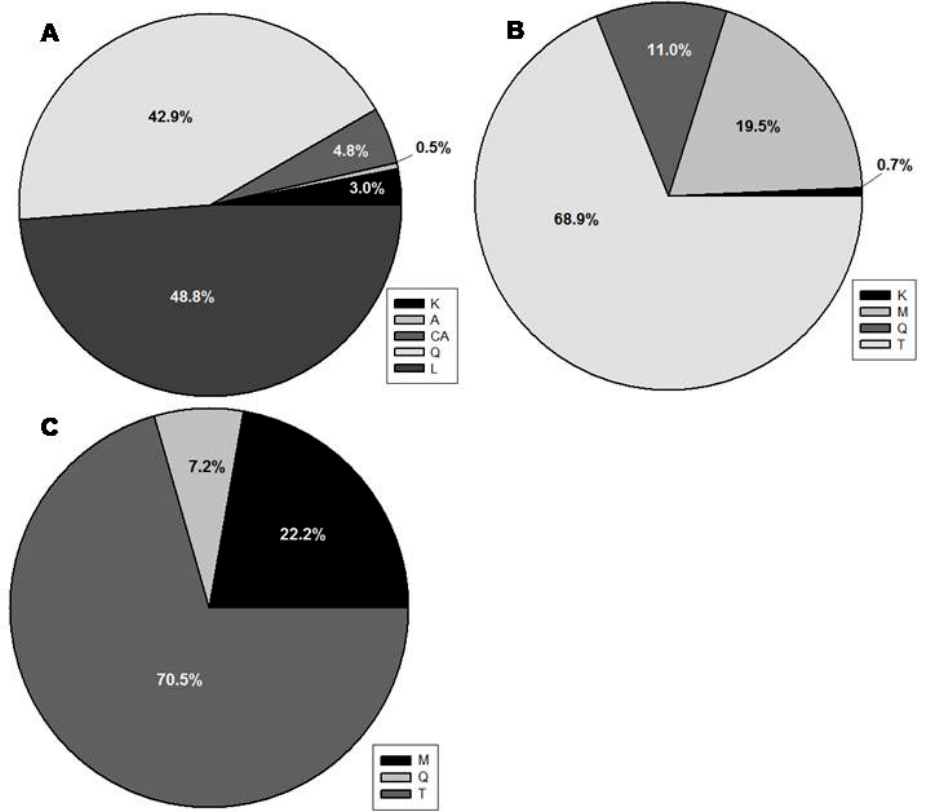
Figure 2. Percentage of each phenolic class (K—kaempferol derivatives; A—apigenin derivatives; CA—caffeic acid derivatives; L—luteolin derivatives; M—myricetin derivatives; Q—quercetin derivatives; T—tannin derivatives) relative to the total phenolic content (TPC—100%) in extracts of